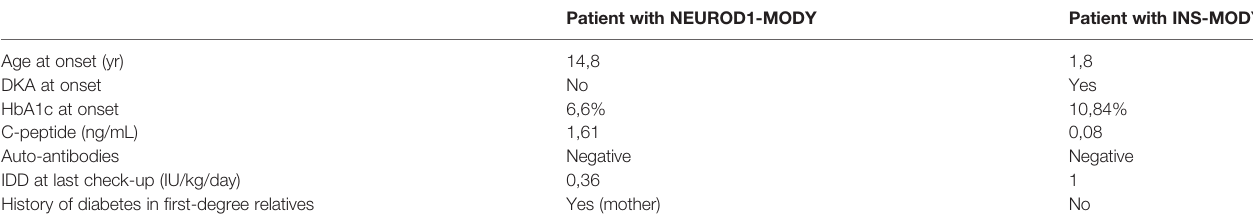
TABLE 2 | Clinical and biochemical characteristics of the 2 patients diagnosed with monogenic